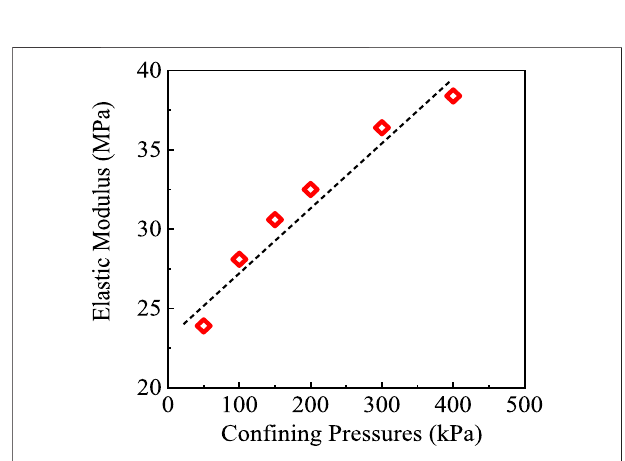
FIGURE 10 | Relationship between E 0 and σ 3